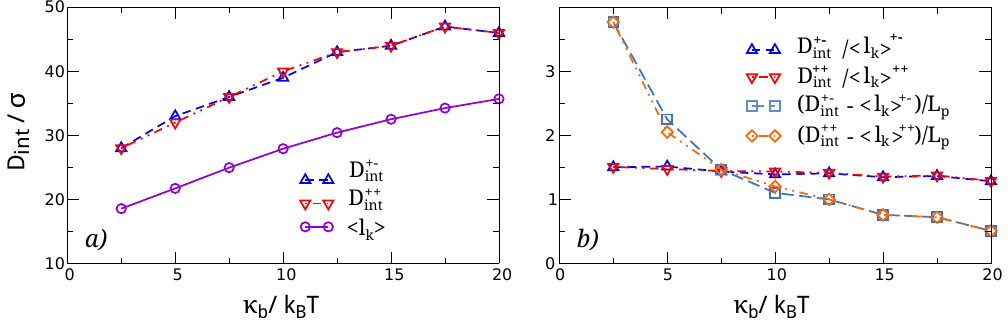
Figure 6. ( a ) Interaction distances of separated knots as a function of κ b . For comparison, we also report the knot size averaged between the ( ++ ) and ( + − ) systems, (cid:104) l k (cid:105) . Note that the interaction distance is always larger than (cid:104) l k (cid:105) ; ( b ) Two different rescaling of D int : D int / (cid:104) l k (cid:105) and ( D int − (cid:104) l k (cid:105) ) / L p , with L p being the persistence length of the chain.